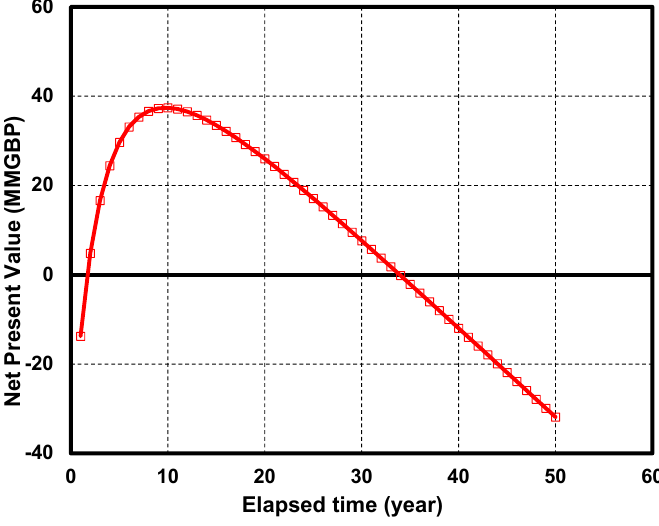
Figure 4. Workflow of Risk of Commercial Failure (RCF) calculation.